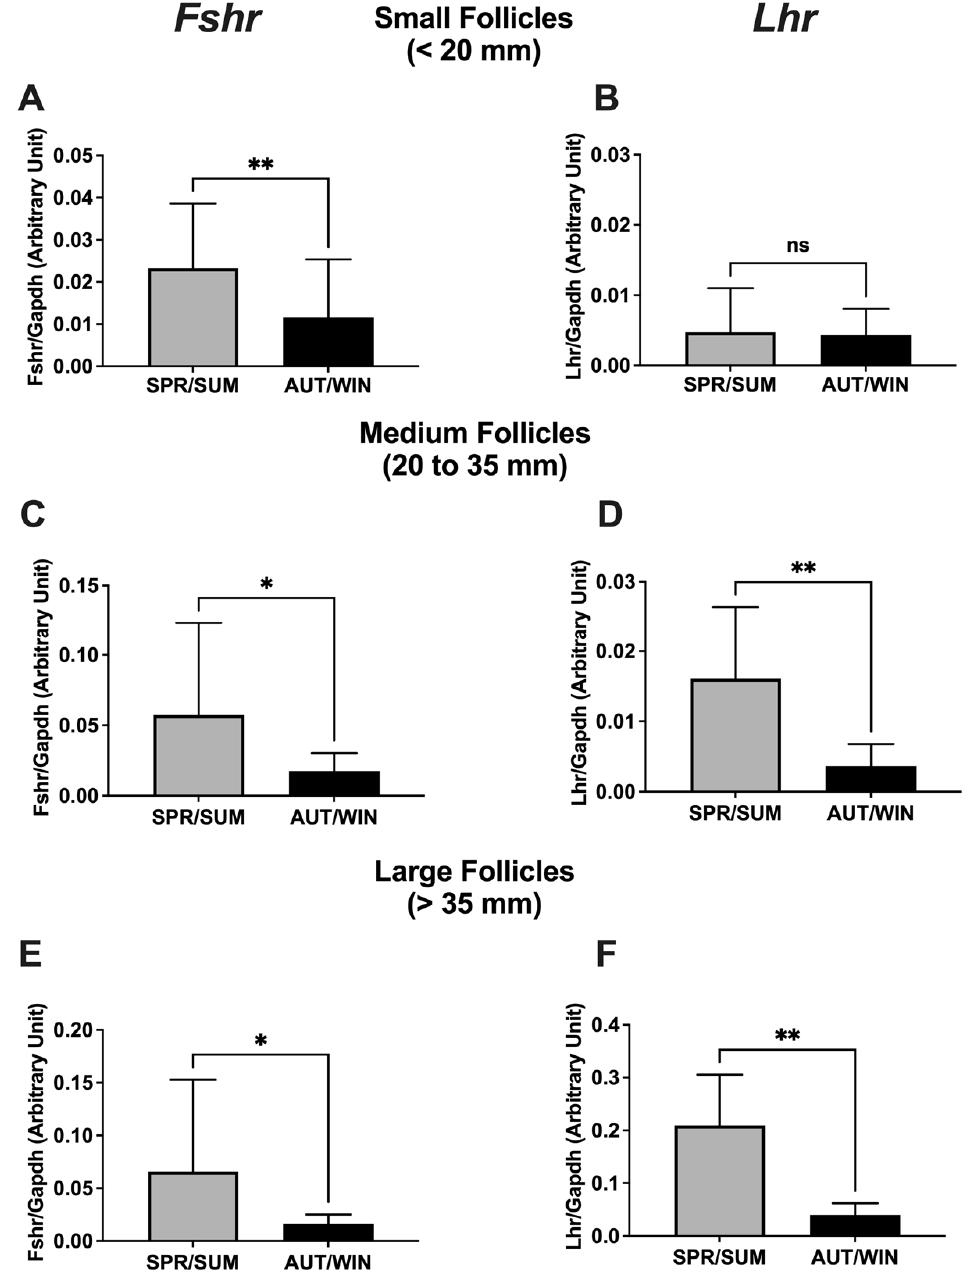
Figure 1. Seasonal distribution of the mRNA expression of Fshr ( A , C , E ) and Lhr ( B , D , F ) genes in mare ovarian follicles. SPR/SUM: spring and summer; AUT/WIN: autumn and winter. Non-parametric Mann–Whitney test was used to determine significant differences (plotted as mean ± SEM). Asterisks represent season differences (* p < 0.05; ** p < 0.01). ns: non-significant. Reference gene: Gapdh . Table 2. Seasonal distribution of the number of follicles (Means ± SEM) evaluated one day before the follicular cell recovery.